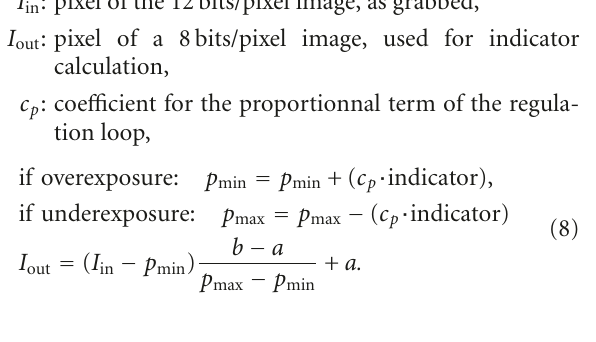
c p : coe ffi cient for the proportionnal term of the